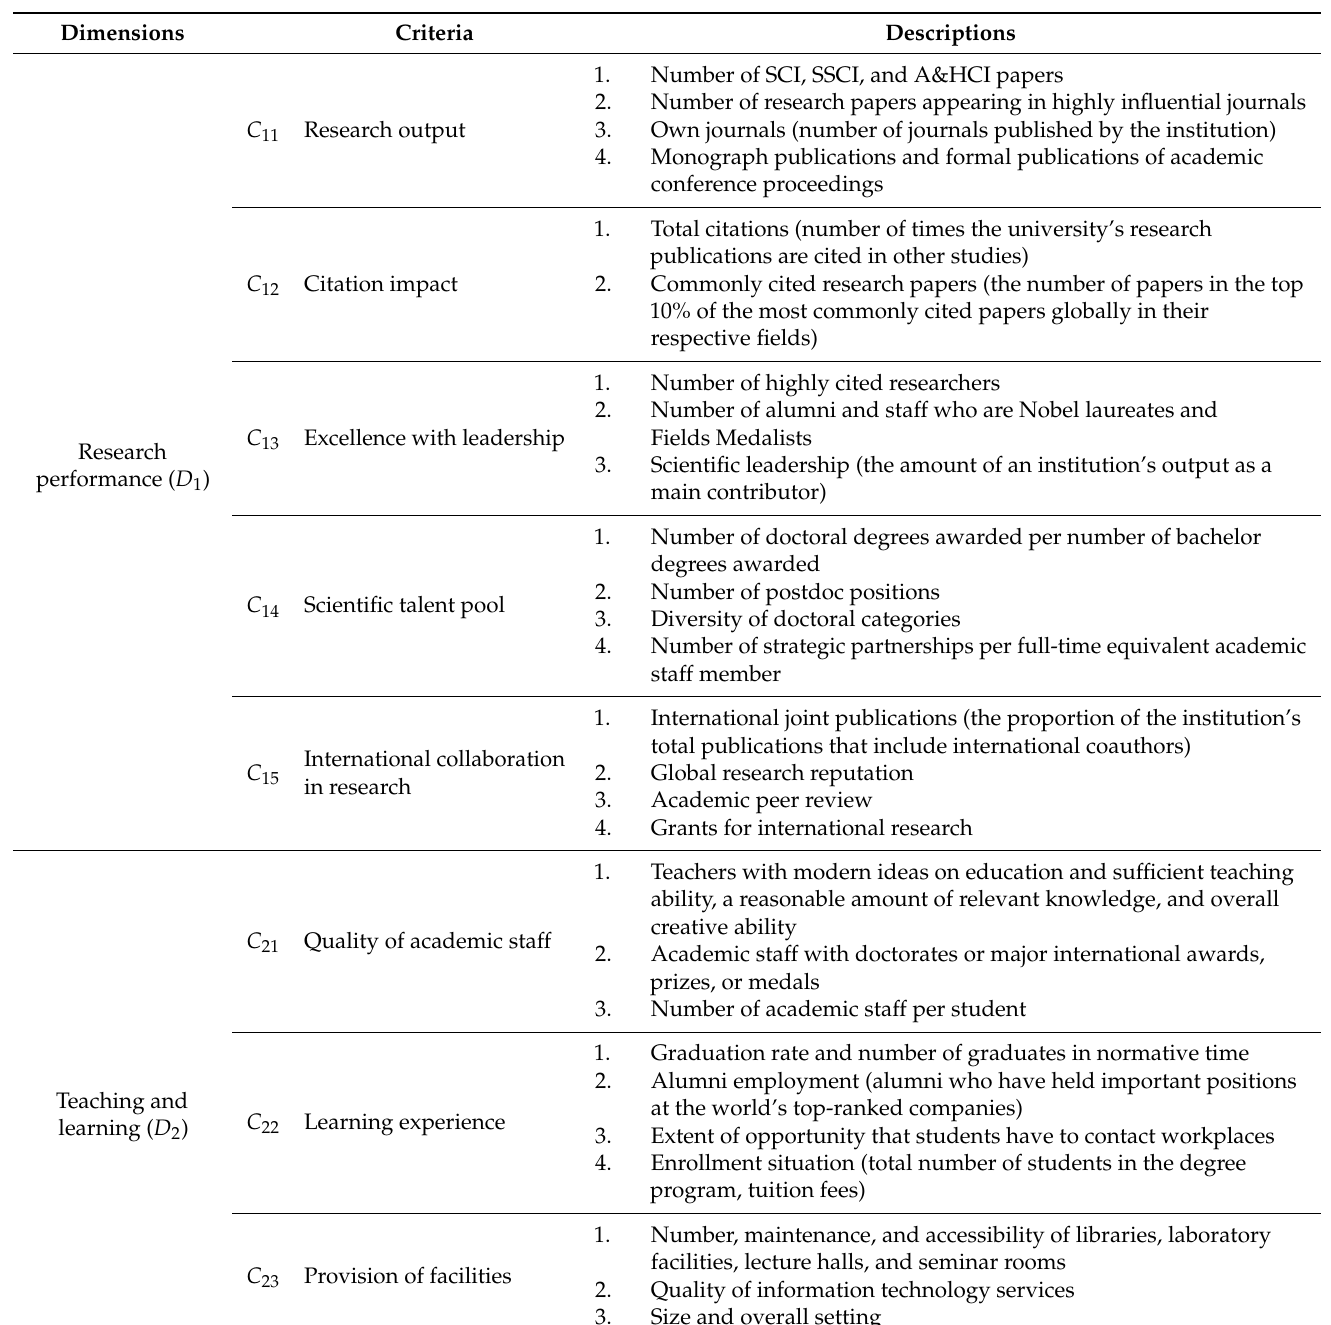
Table 2. Evaluation criteria for East Asian catch-up universities